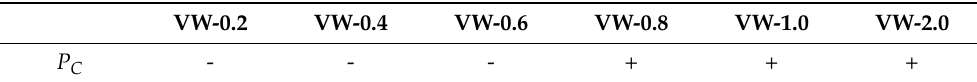
Table 3. Positive and negativity of the capillary force